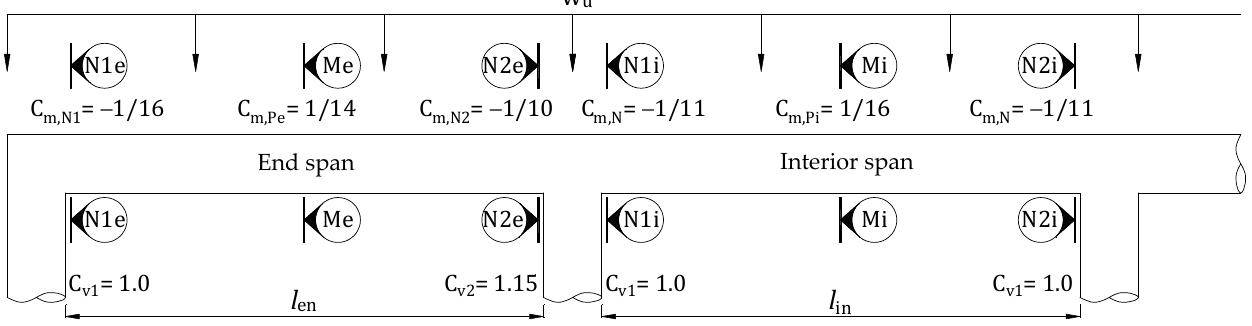
Figure 2. Shear and moment coefficients for continuous RC slabs with column supports, according to ACI 318M.